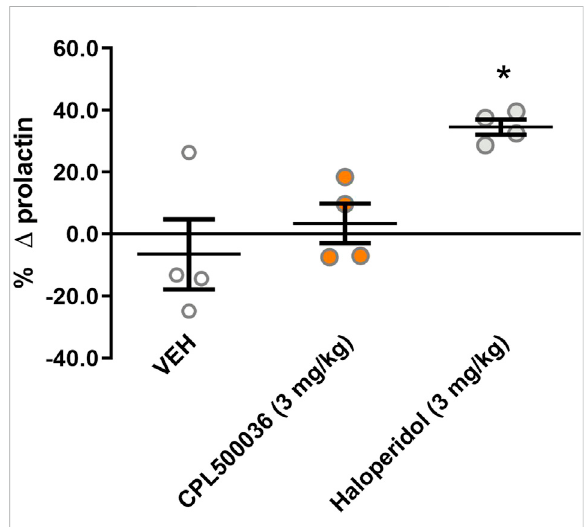
FIGURE 5 CPL500036 does not in fl uence the prolactin level in rats. Animals were given (p.o.) vehicle, CPL500036 (3 mg/kg) or haloperidol (3 mg/kg). The results represent the relative change in the prolactin level before and 2 h after administration of the compound. Dataarethemean±SD.* p < 0.05vs . vehiclegroupby Dunn ’ s post hoc test; n =